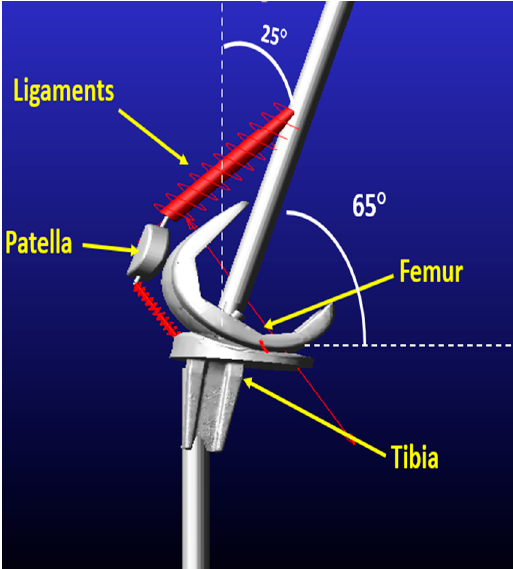
Figure 9. Multibody Model at the position of 25°.